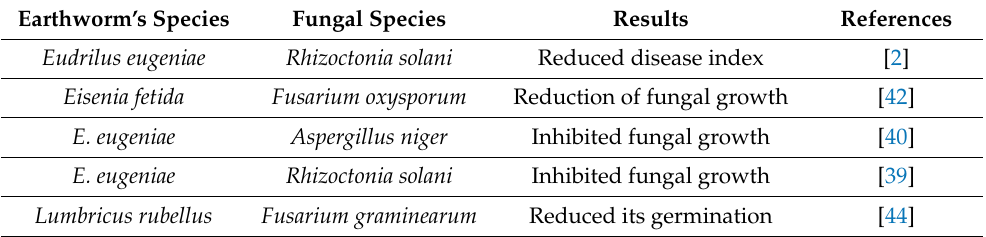
Table 3. Antifungal activity shown by coelomic fluid from different species of earthworms. Earthworm’s